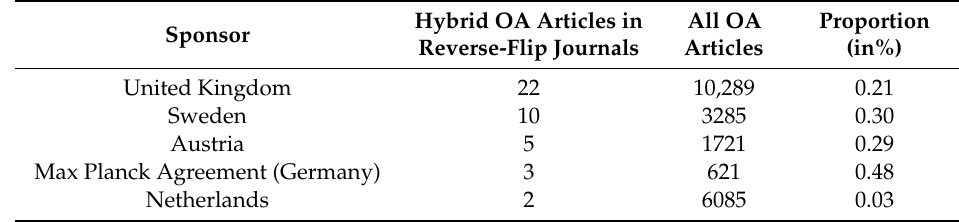
Table 5. The number and relative share of hybrid OA articles in reverse-flip journals as part of Springer Compact, paid for by institutions reporting expense data to the Open APC initiative.